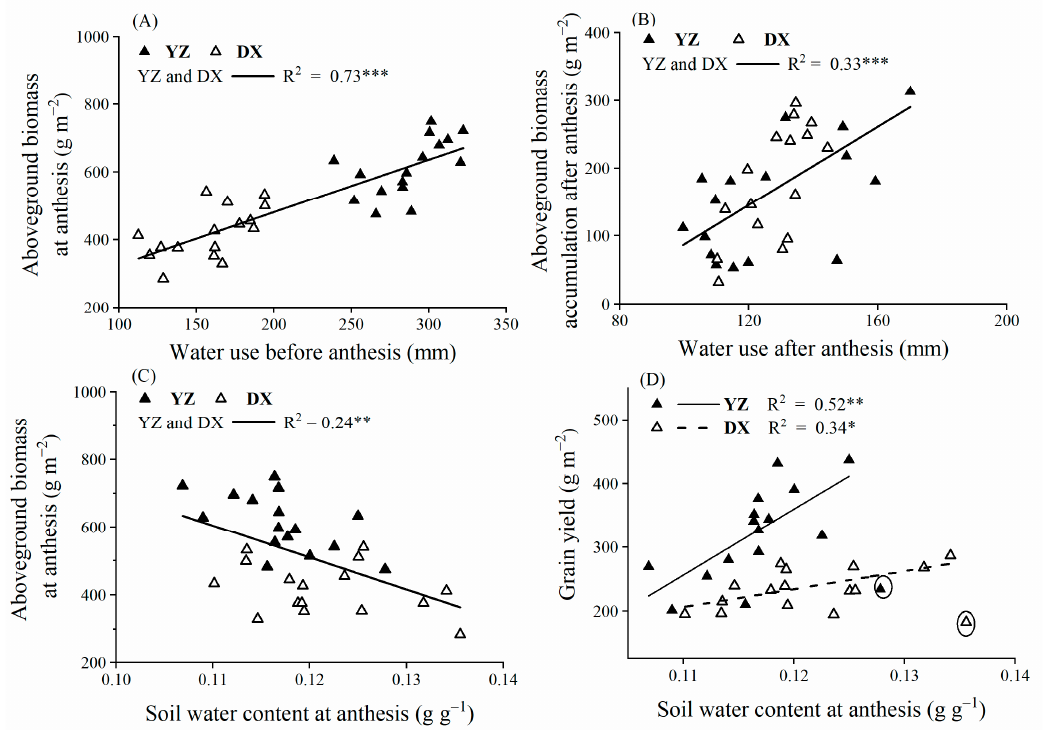
Figure 5. The relationships between: ( A ) water use before anthesis and aboveground biomass at anthesis; ( B ) water use after anthesis and aboveground biomass accumulation after anthesis; ( C ) soil water content at anthesis and aboveground biomass at anthesis; ( D ) soil water content at anthesis and grain yield at YZ and at DX. Fitted data are the mean of three replications for 16 genotypes; a single regression is fitted where the two sites did not differ significantly. The circled genotype in ( D ) is 021-128, which is not included in the linear regression. * p < 0.05; ** p < 0.01; *** p < 0.001.